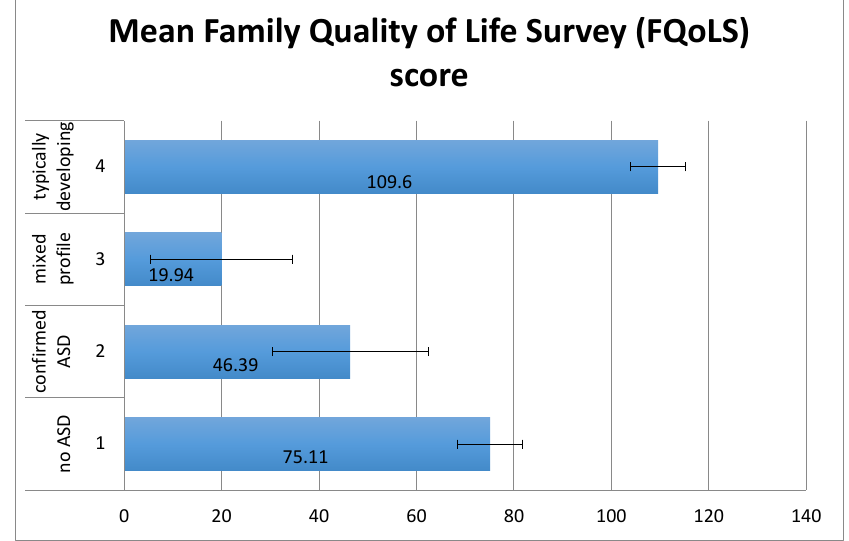
Figure 3. Mean FQoLS scores by group. Error bars show ±1 standard error.